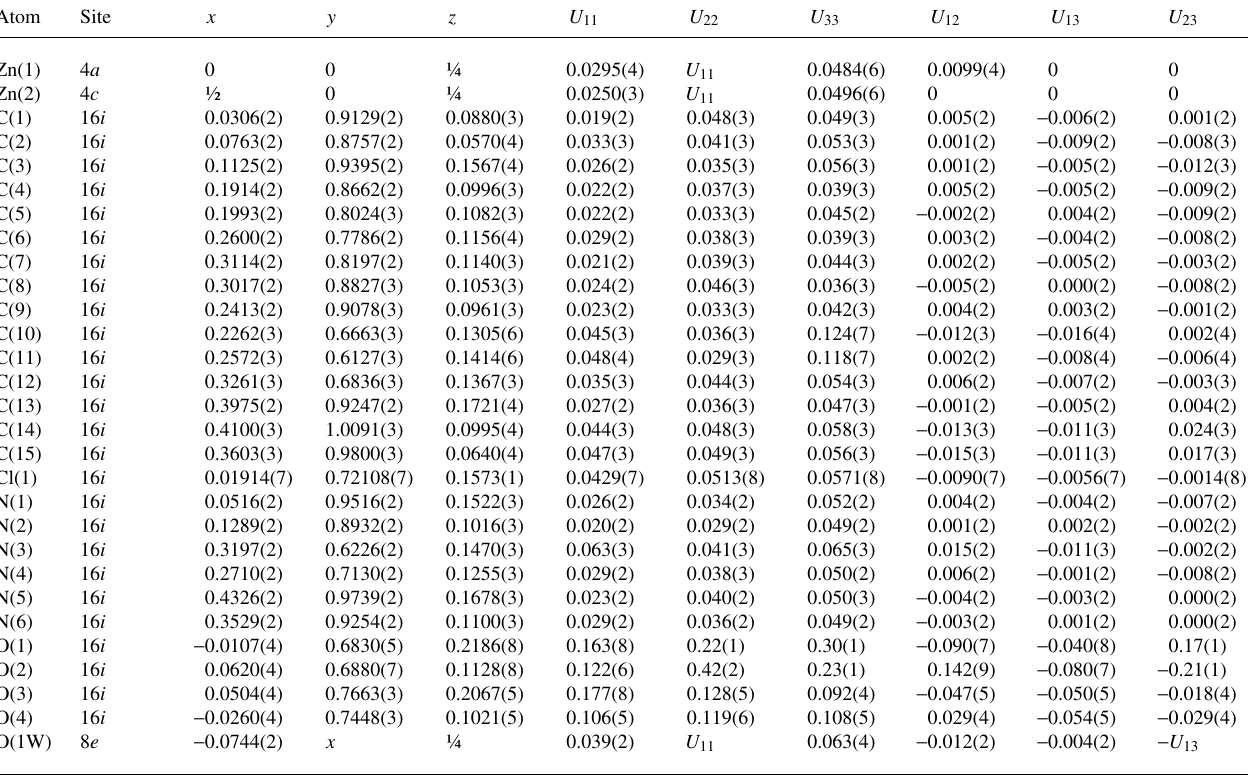
Table 3. Atomic coordinates and displacement parameters (in Å 2 )